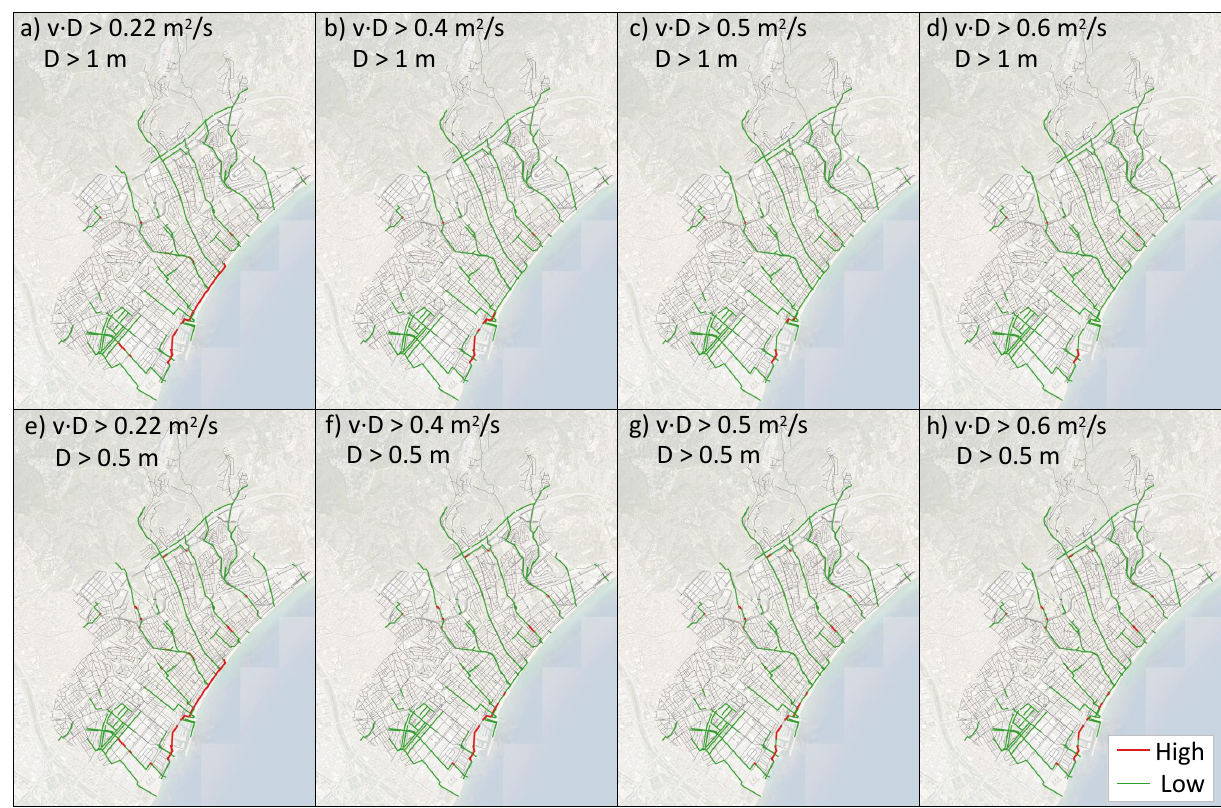
Figure 6. Hazard map of visitable sewer conduits in maximum flow scenario. Green lines = low-hazard, red lines = high- hazard and grey lines = nonvisitable